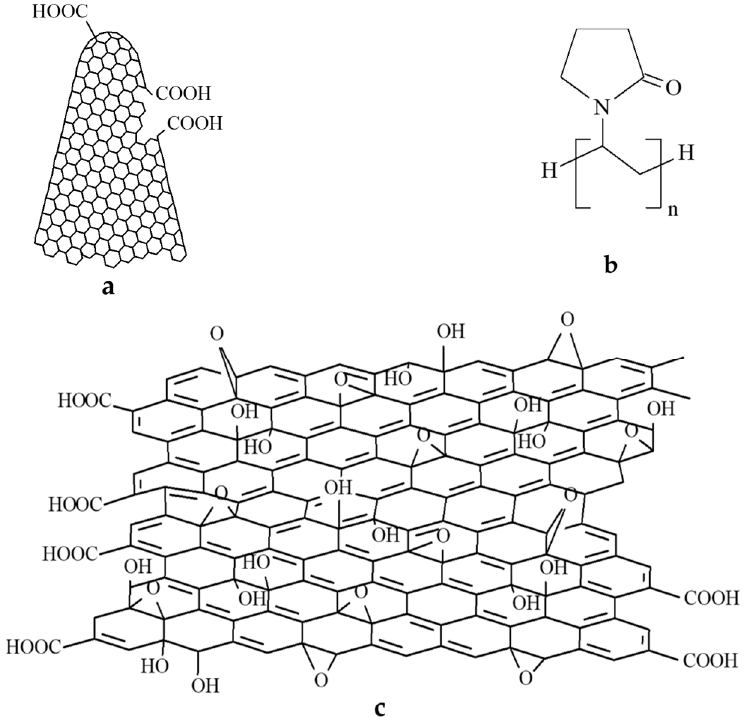
Figure 1. The structure of ( a ) CNHox, ( b ) PVP and ( c ) GO.